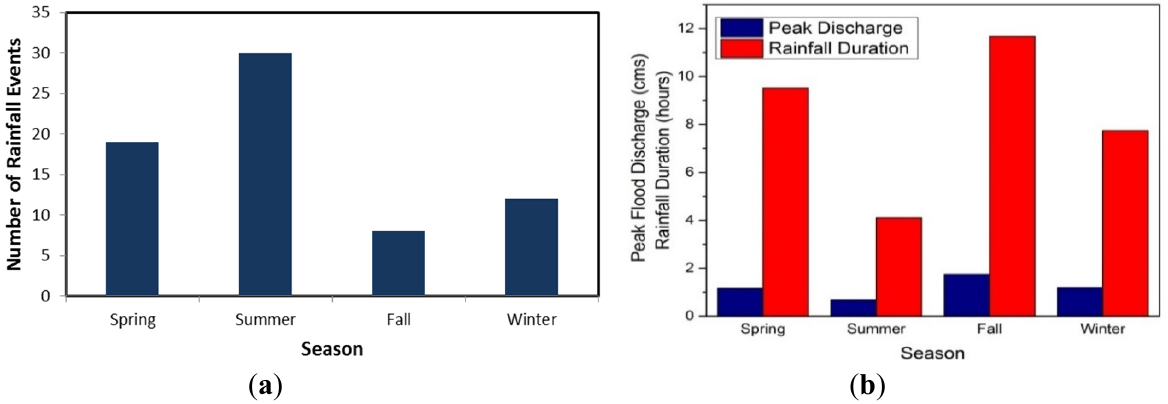
Figure 3. ( a ) Number of rainfall events between March 2007 and July 2010 within the Allen Creek Watershed categorized by meteorological season. Includes a total of 69 events; ( b ) Average rainfall duration and the generated peak discharge associated with each precipitation